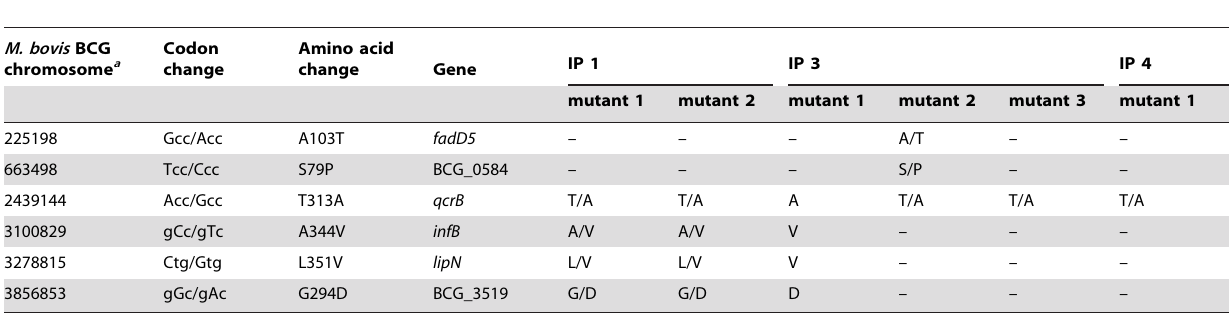
Table 3. Single nucleotide polymorphisms detected in M. bovis BCG spontaneous mutants resistant to IP compounds.